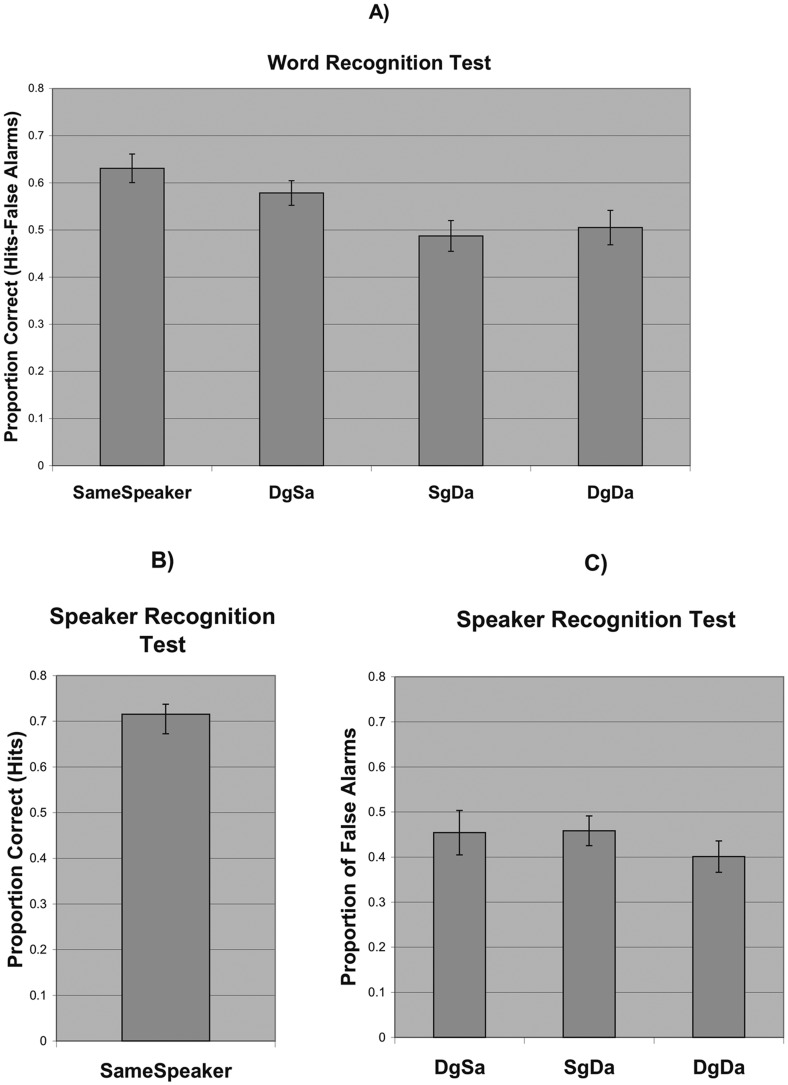
a) Accuracy for the Word Recognition Test, b) Accuracy for the Source recognition Test, c) False Alarms for the Source recognition Test.Note that DgSa  =  different gender/same accent condition, SgDa  =  same gender/different accent condition and DgDa  =  different gender/different accent condition. Error bars represent standard error.